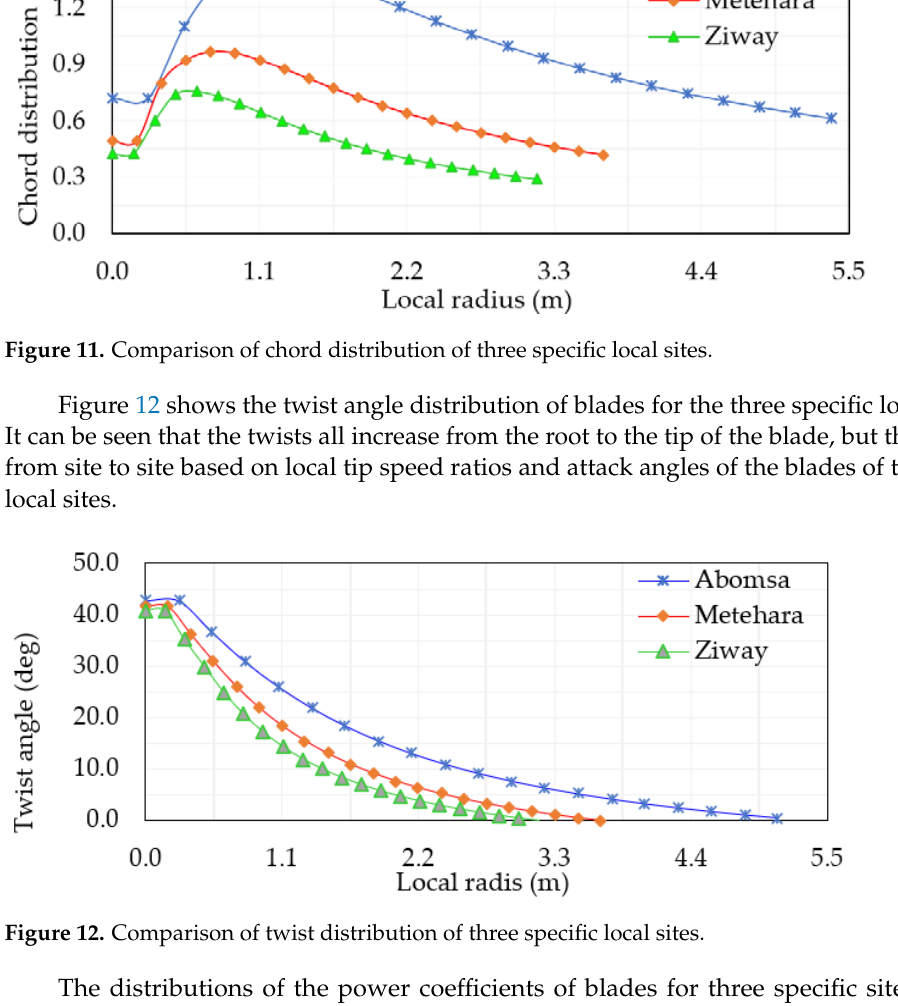
Figure 12. Comparison of twist distribution of three specific local sites.